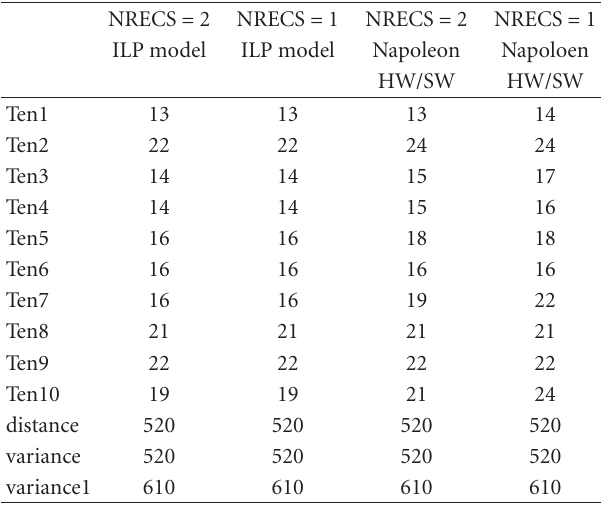
Table 4: ILP/heuristic results comparison.